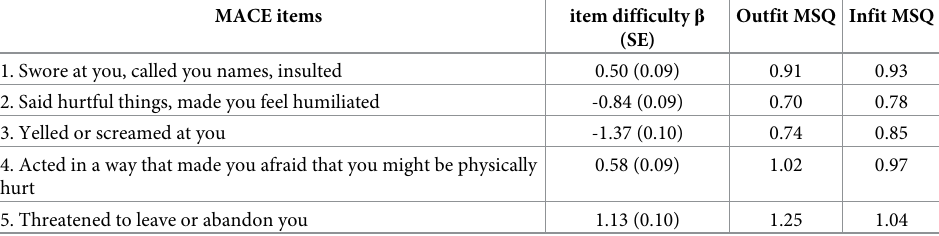
Table 2. Rasch analysis of parental verbal abuse subscale.